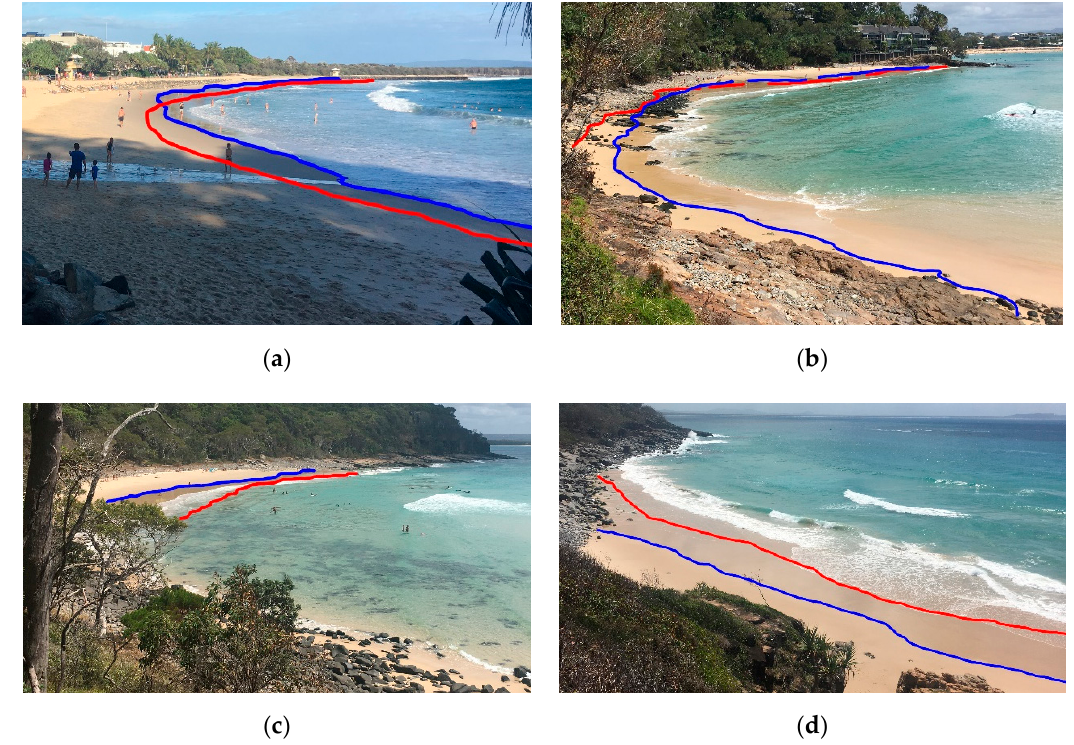
Figure 6. ( a ) Main Beach shoreline comparison. The red line indicates the 18 January 2019 shoreline position while the blue line and photo are from 8 March 2019. Little Cove ( b ), Tea Tree ( c ) and Granite Bay ( d ) shoreline comparison.